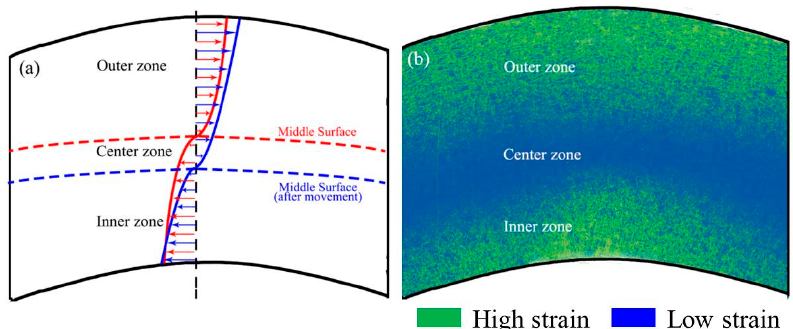
Figure 10. Schematic diagram of stress and strain distribution during bending process. ( a ) Stress distribution; ( b ) Strain distribution.